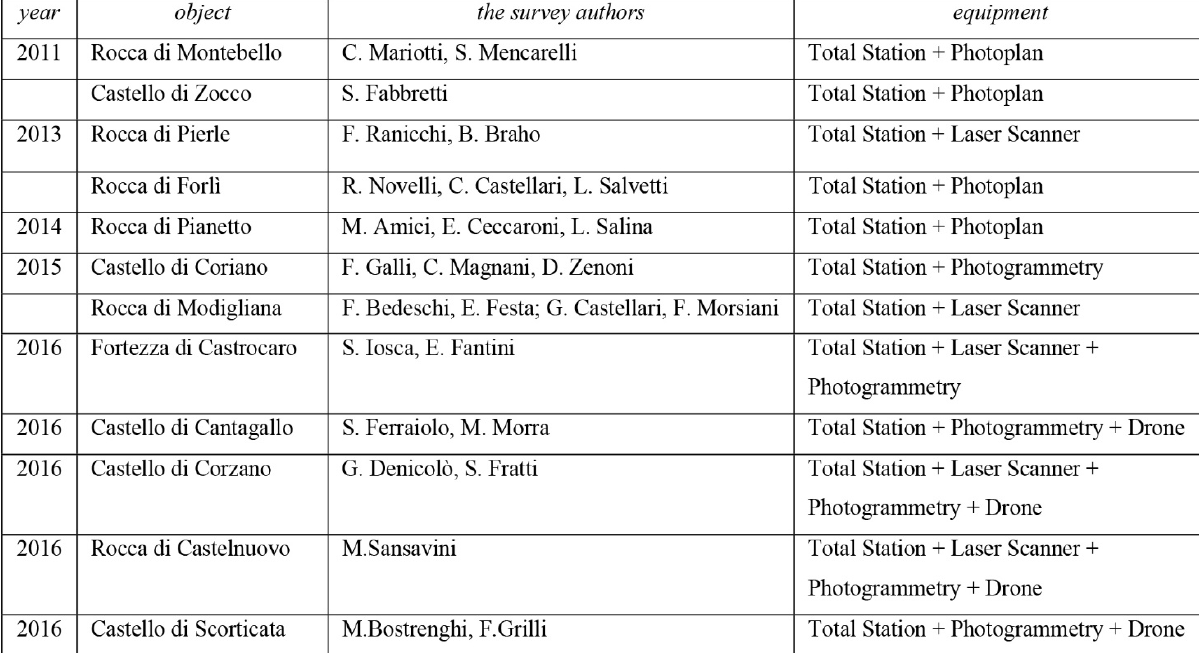
Table 1. Chronological list of the architectural surveys with the instruments